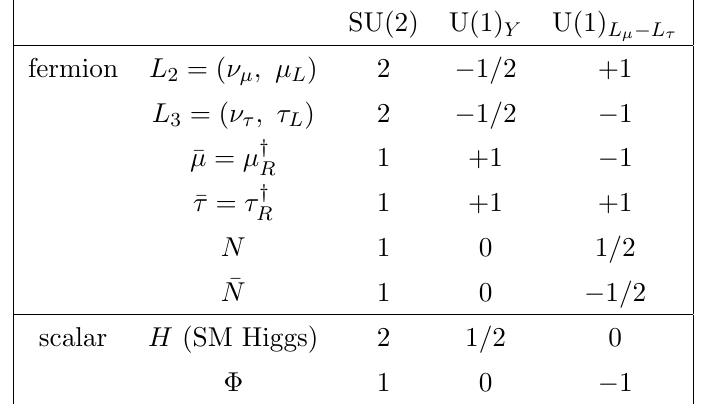
Table 1 . Charge assignments of the particles in the model, where the fermions are represented by the left-handed 2-component Weyl